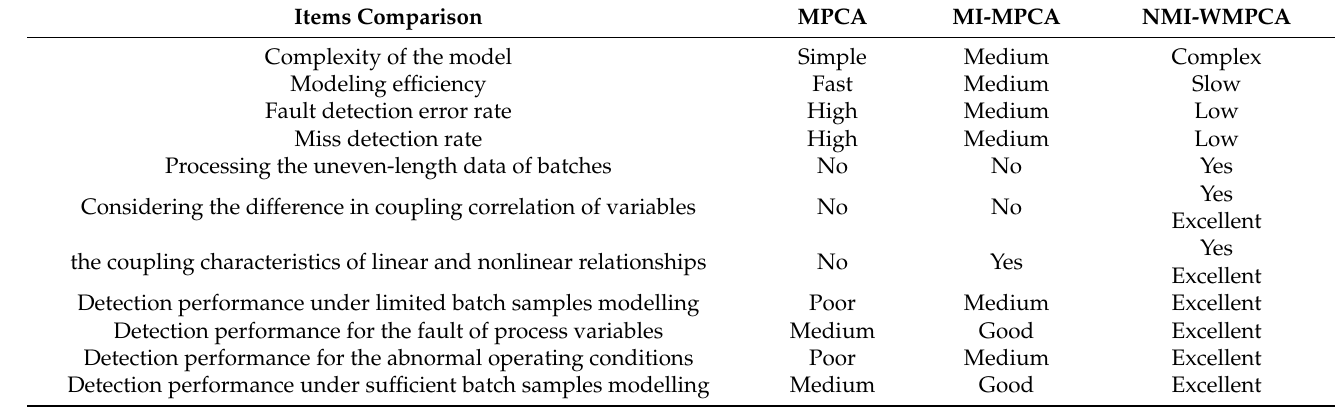
Table 8. Comparisons of advantages and disadvantages of MPCA, MI-MPCA, and